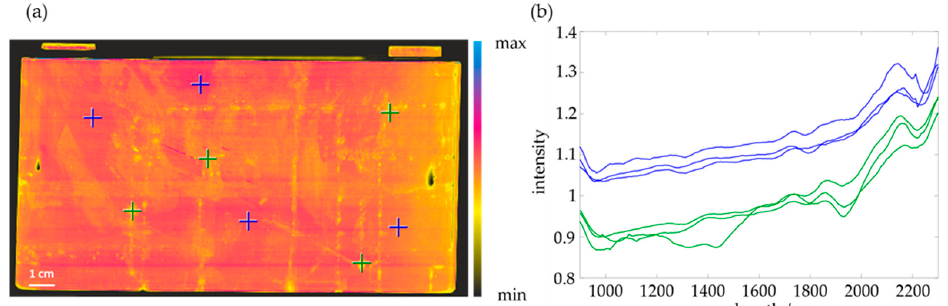
Figure 4. ( a ) Color-coded image of a battery cell before laser cleaning at a wavelength of 1500 nm; ( b ) Example spectra of the cell. The positions of the displayed sample spectra are marked by the colored crosses. The blue spectra represent areas that appear clean, and the green spectra represent areas that appear contaminated.